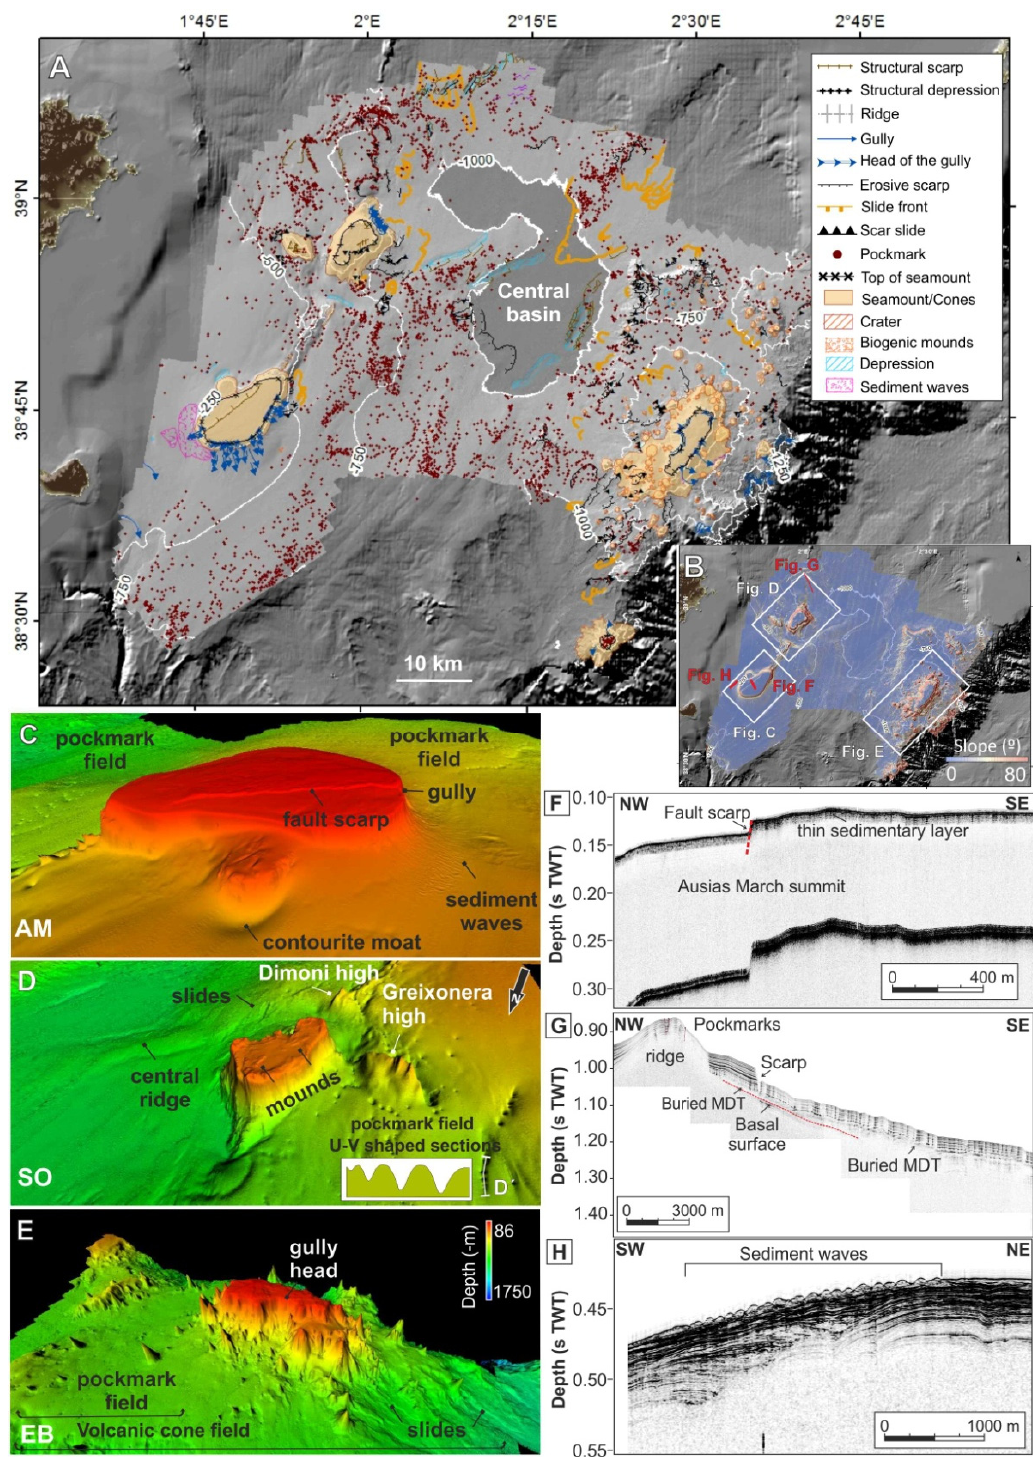
Figure 4. Bathymetry and geomorphology of the seafloor in the Mallorca Channel: ( A ) Morphological map showing the main morphological features and domains of the study area; ( B ) slope map showing bathymetric contours at each 250 m and the location of the 3D bathymetric models and parametric profiles; ( C – E ) overview 3D bathymetric map of the main edifices of the study area: Ses Olives, Ausias March, and Emile Baudot seamounts and Greixonera and Dimoni highs; ( F – H ) parametric profiles showing the internal structure of the main morphological features present in the study area.